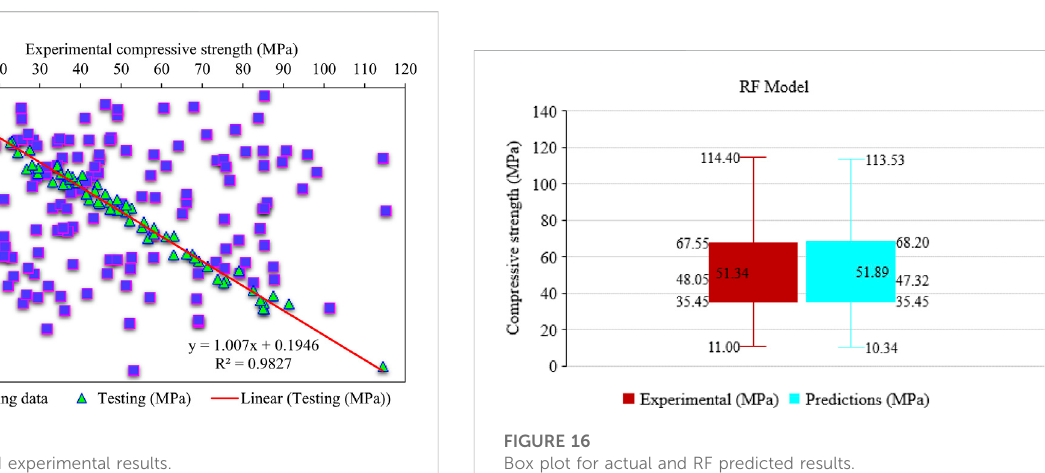
FIGURE 14 RF predicted and experimental results.